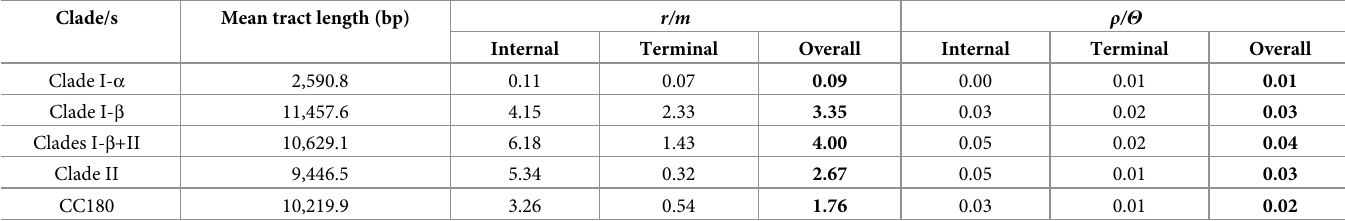
Table 2. Recombination among CC180 lineages. The number of polymorphisms introduced via recombination to mutation ( r/m ) and the number of recombination events to polymorphisms introduced by mutation ( ρ/ Θ ) are reported for internal and terminal branches of dominant clades. Recombination occurring on internal branches is considered ancestral while terminal branches represent recent events. The overall recombination rates are also reported. Clade/s Mean tract length (bp) r/m ρ/ Θ Internal Terminal Overall Internal Terminal Overall Clade I- α 2,590.8 0.11 0.07 0.09 0.00 0.01 0.01 Clade I- β 11,457.6 4.15 2.33 3.35 0.03 0.02 0.03 Clades I- β +II 10,629.1 6.18 1.43 4.00 0.04 Clade II 9,446.5 5.34 0.32 2.67 0.05 0.01 0.03 CC180 10,219.9 3.26 0.54